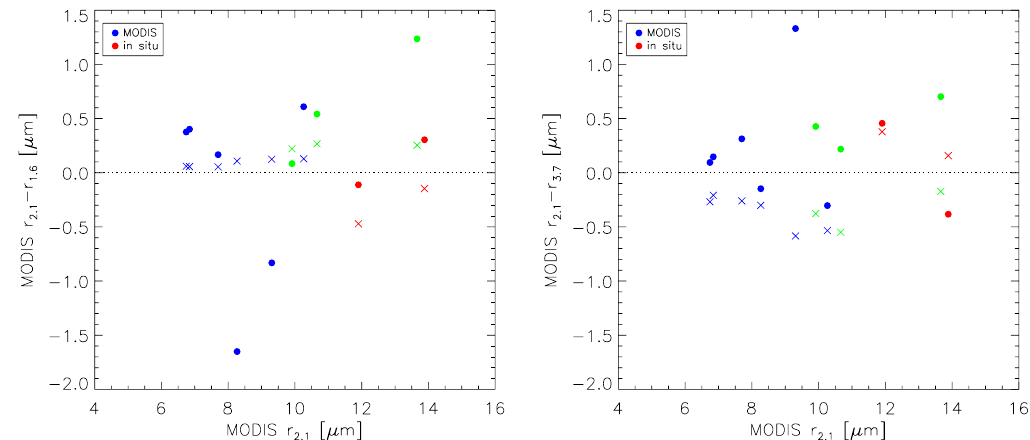
Fig. 8. Difference between r e retrievals plotted as a function of the MODIS r 2 . 1 retrievals. Dots represent the differences between MODIS retrievals and crosses represent the differences between synthetic weighted retrievals using the in situ profiles.